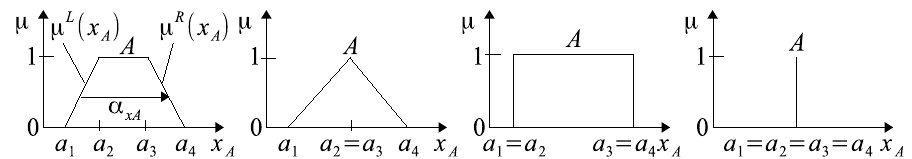
Figure 2. Trapezoidal fuzzy number and its special